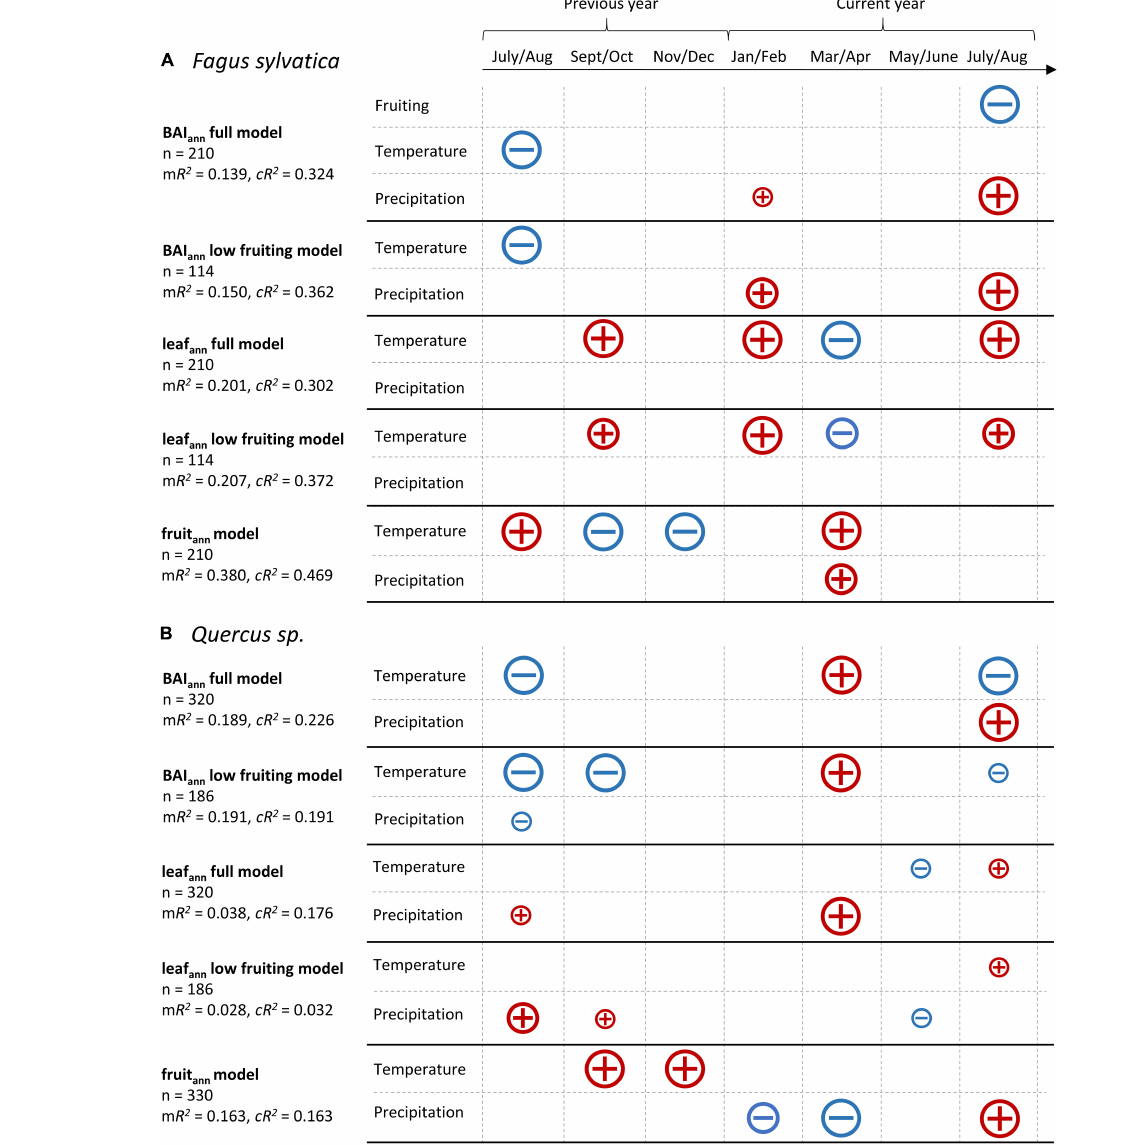
FIGURE 2 | Results from averaged linear mixed-effects models assessing the effects of weather cues and fruit production (fruit ann ) on basal area increment (BAI ann ) and leaf production (leaf ann ), and the effects of weather conditions on fruit ann . (A) Fagus sylvatica , (B) Quercus sp. Weather conditions were used as deviations from the 2-monthly long-term mean temperatures and precipitation sums of the previous and current year. Full model: Includes all measured years on all plots, low fruiting model: Includes only years with less than 10% of maximum fruit production, fruit ann model includes all measured years on all plots. + : Increase, –: Decrease, symbol size shows parameter importance in the averaged models. m R 2 : Marginal R 2 , c R 2 : Conditional R 2